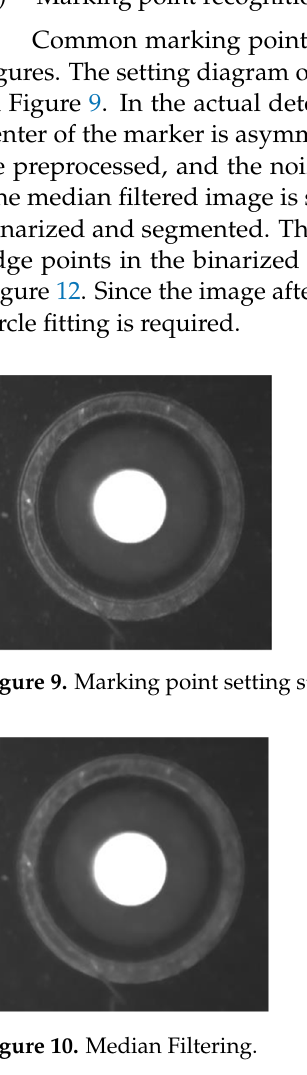
Figure 11. Image after binarization. Figure 12. Pixel edge extraction. After the pixel edges are obtained, the least squares fitting is performed on the ob ‐ tained pixel edge points. The least squares circle fitting equation is 2